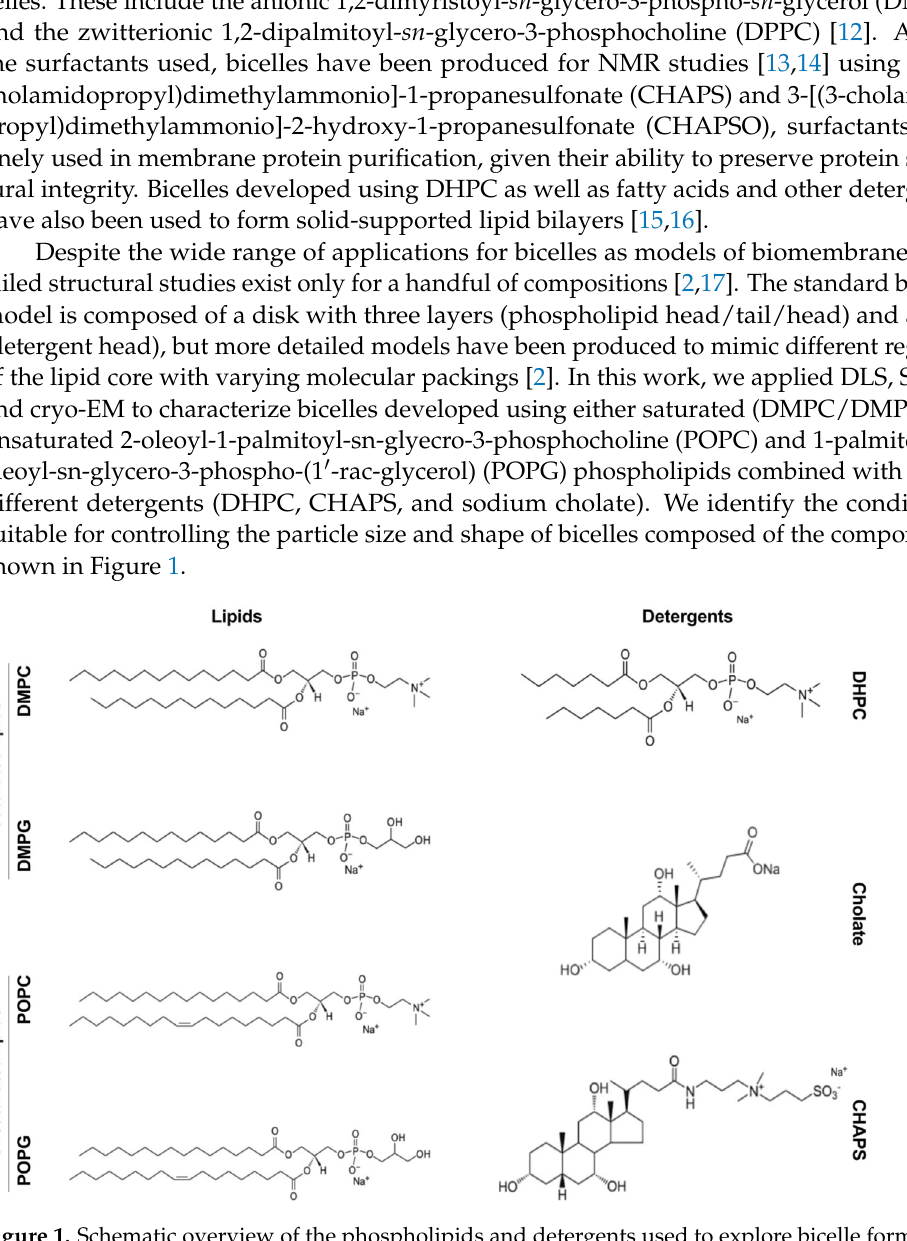
Figure 1. Schematic overview of the phospholipids and detergents used to explore bicelle formation in this study.